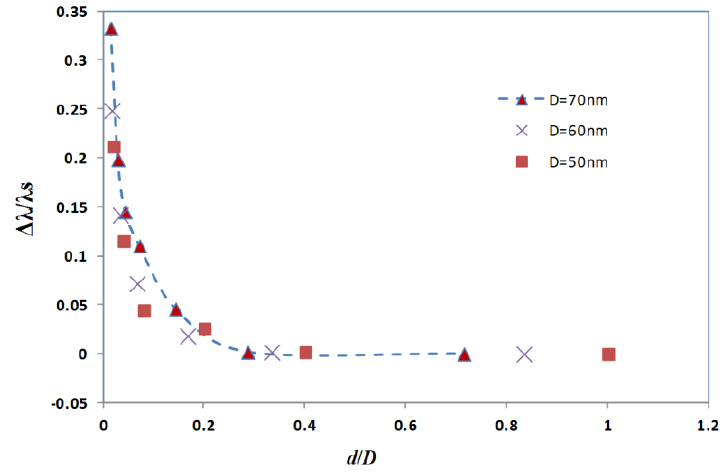
Figure 5. The influence of spacing on near field coupling strength between four gold